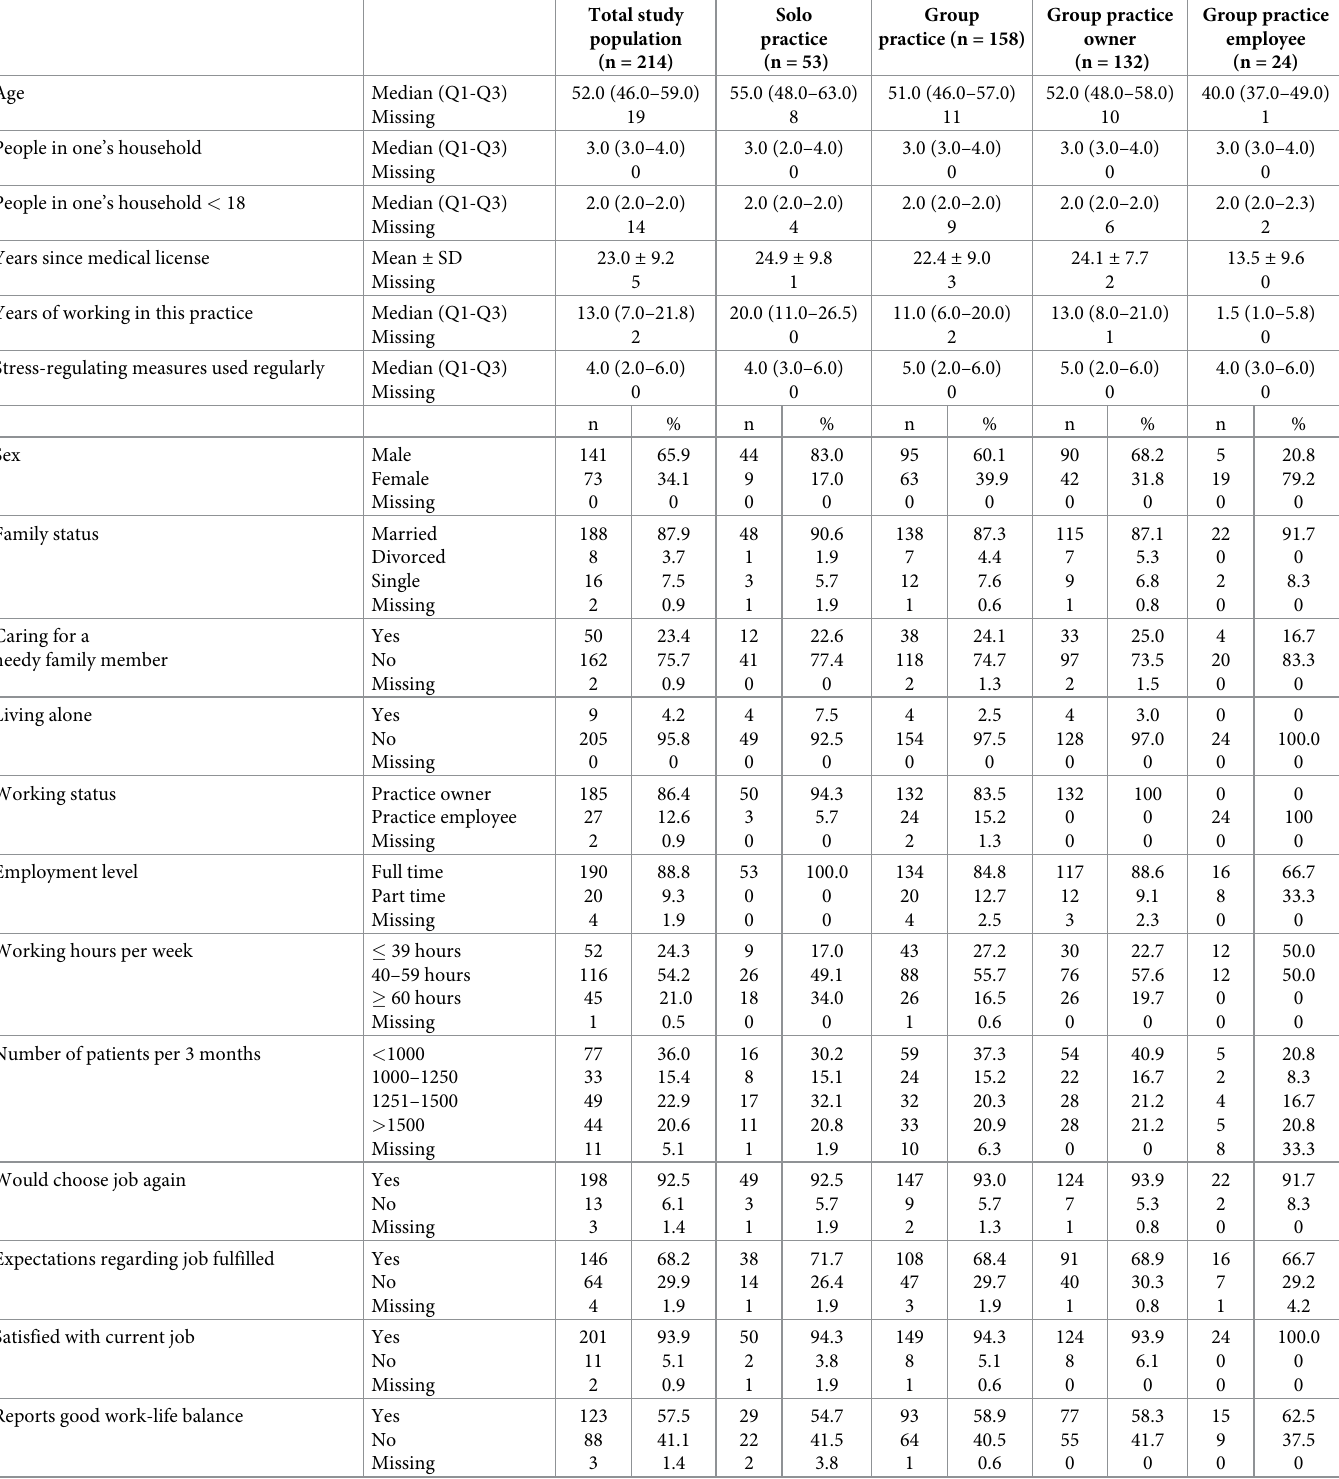
Table 1. Characteristics of the participating physicians (n = 214): total population and stratified by solo and group